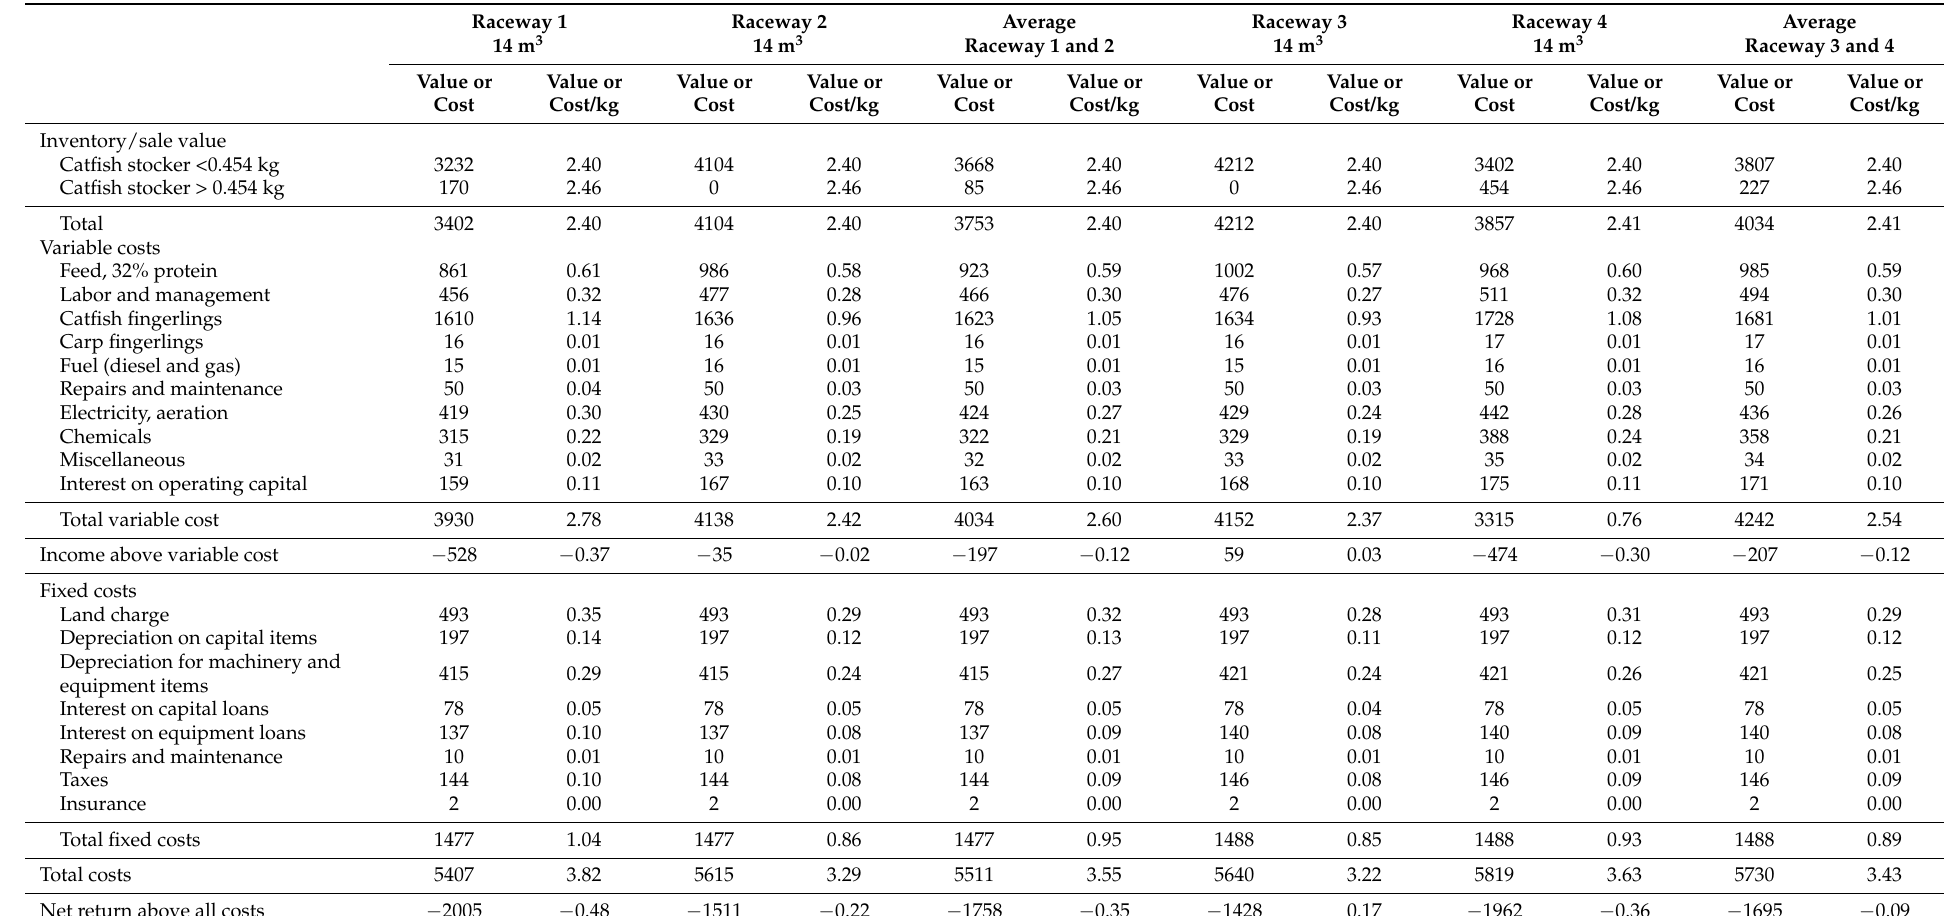
Table 7. Stocker enterprise budgets for four in-pond raceway system (IPRS) producing stocker hybrid catfish, channel catfish Ictalurus punctatus furcatus , with each raceway placed in a 0.4 ha pond, USD, 2018 ♂